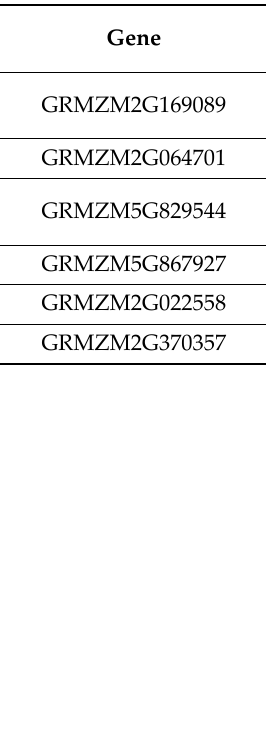
Table 3. Genes involved in fatty acid synthesis and